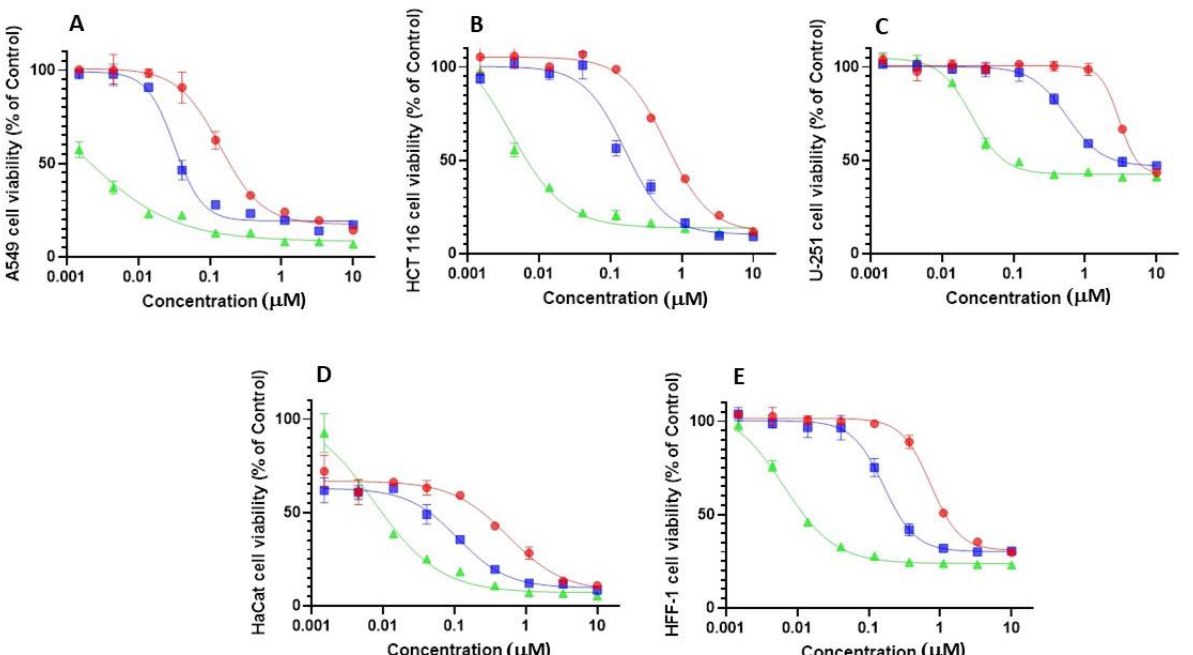
Figure 7. Effect of bufalin, bufalin 2,3-ene, and bufalin 3,4-ene on human cancer cell growth. The anti-proliferative activity of the steroids was tested against the NCI-60 cell line panel at the National Cancer Institute (NCI), Bethesda, Maryland, USA according to their standard protocol (https://dtp.cancer.gov/discovery_development/nci-60/methodology.htm, March 27 th , 2022). The ef- fects of bufalin and the novel bufalin derivatives on 6 glioblastoma cell lines ( A – C ) and 7 colorectal cancer cell lines ( D – F ) are shown.